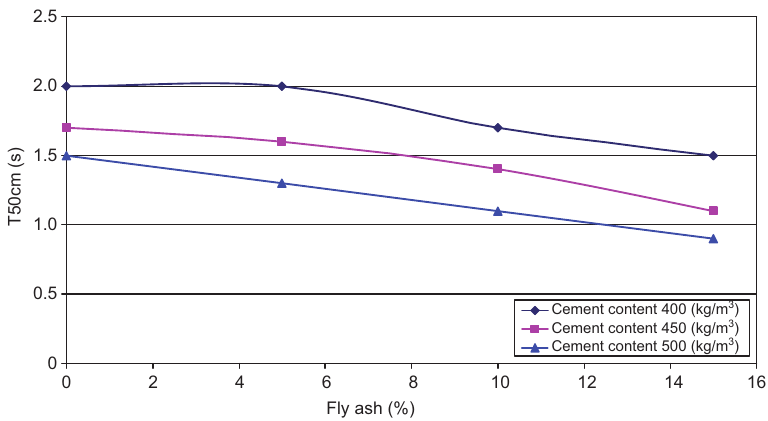
Figure 6 T50 changes for different mixes of